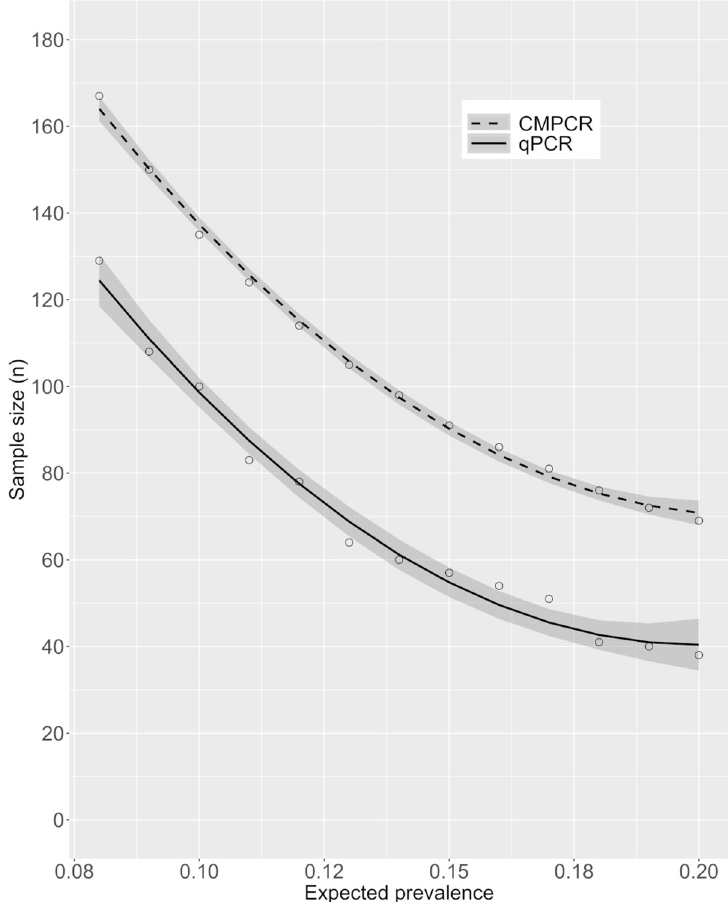
Fig 3. Sample size required to detect Echinococcus multilocularis at various expected prevalence estimates (with 95% CI) in a population of 300 foxes.